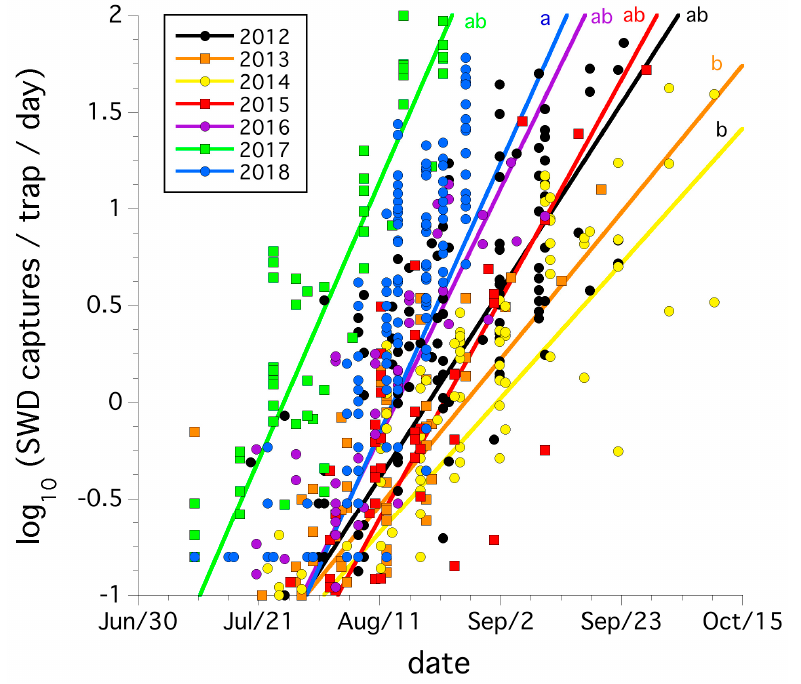
Figure 2. Average trap catches of D. suzukii adults per day (logarithm transformed) over each growing season for each field (2012–2018). The same letters next to each regression line signify that slopes are not significantly different as determined by overlap of slope with 95% confidence intervals.